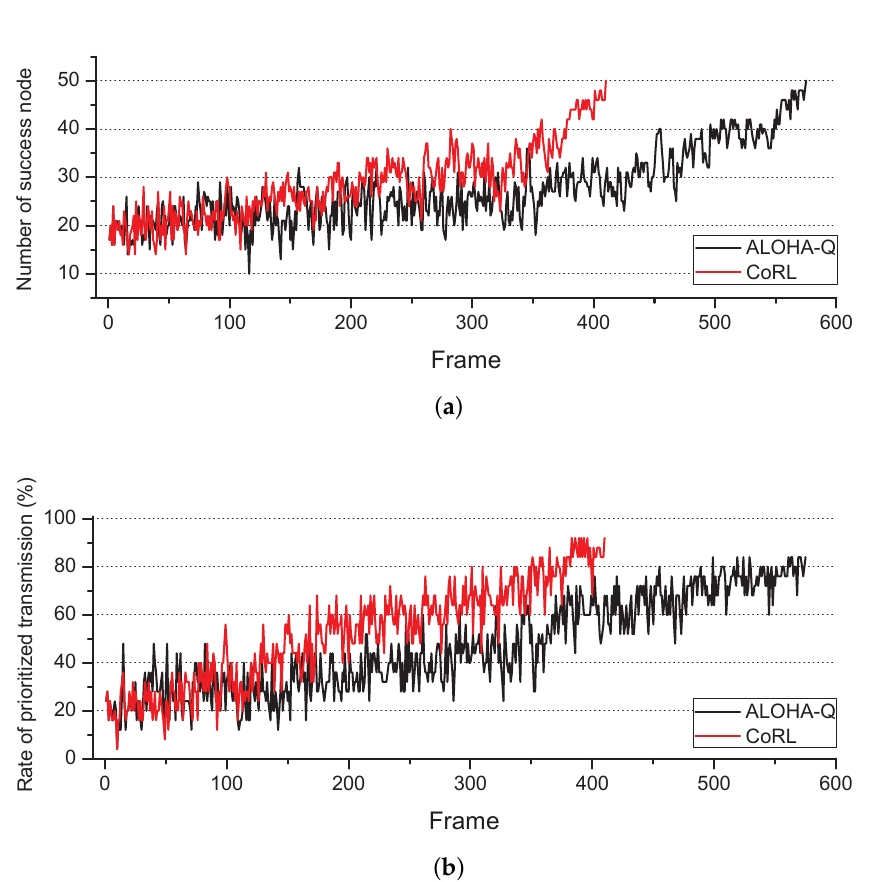
Figure 2. ( a ) Measures the average convergence time of two protocols with prioritized services by the network. The network consists of 50 nodes and the 50 slots per frame. ( b ) The success rate of prioritized services among all services. Success rate of prioritized